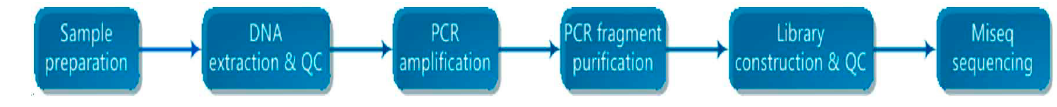
Fig. 1. Microflora diversity experimental